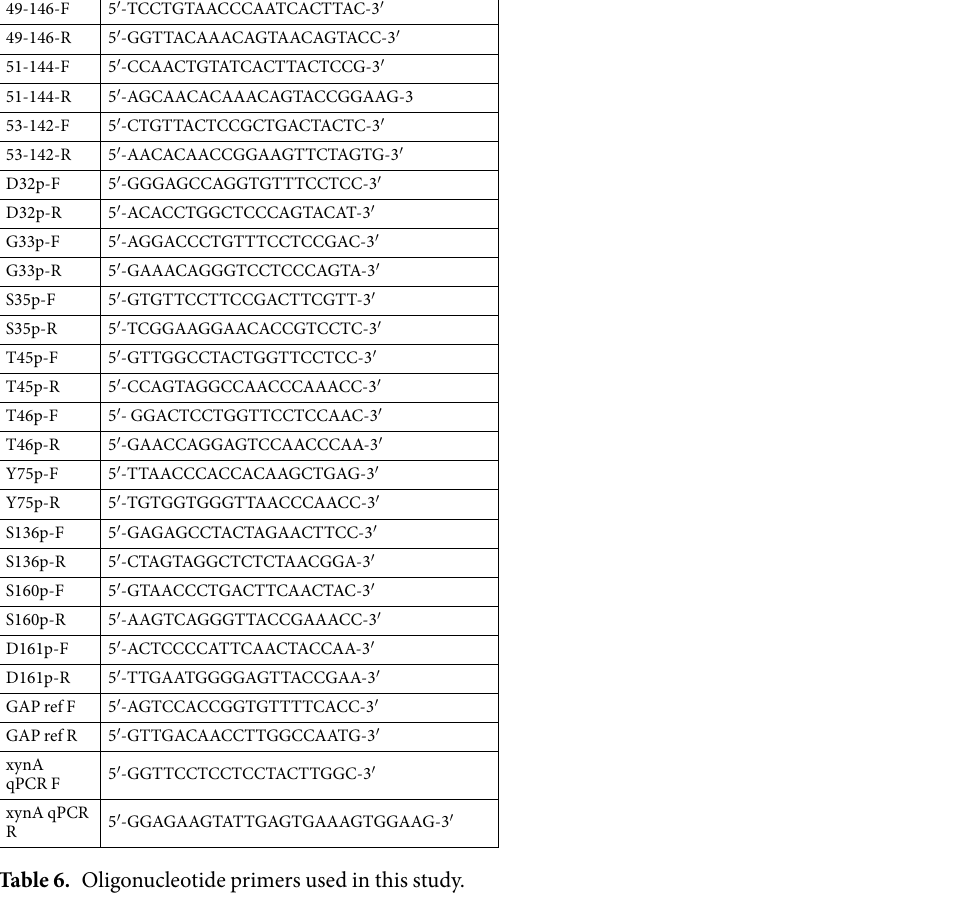
amino acids sequences. The gene mutations were generated by over-lapped PCR with designed primers (Table 6) and transformed into E. coli Top 10. The recombinant plasmids were confirmed by DNA sequencing. Transformation, shake-flask expression and purification of xylanase.